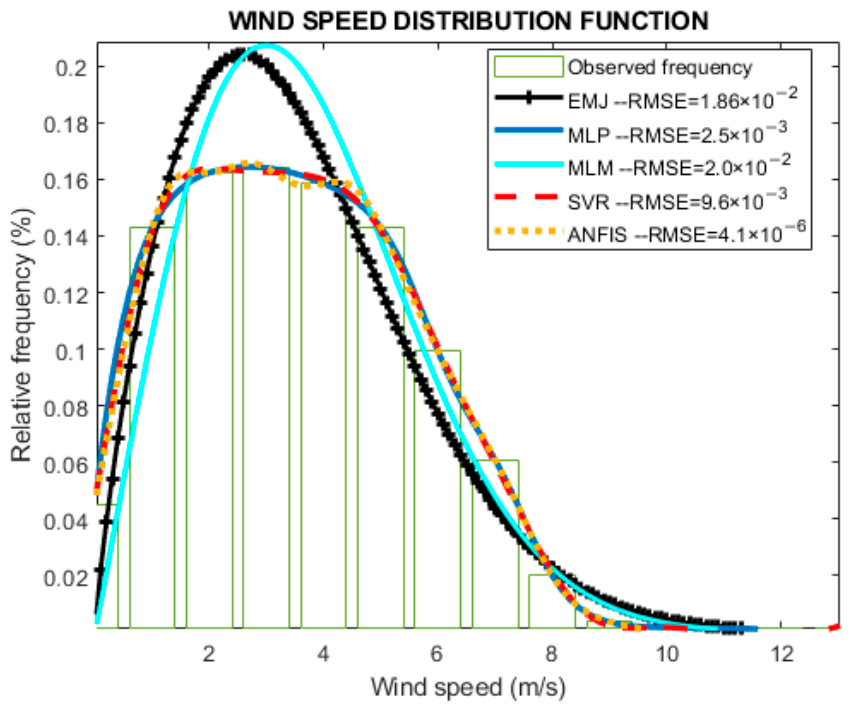
Figure 9. Wind speed distribution function for the site of Lomé.